Question: Describe this figure in one sentence.
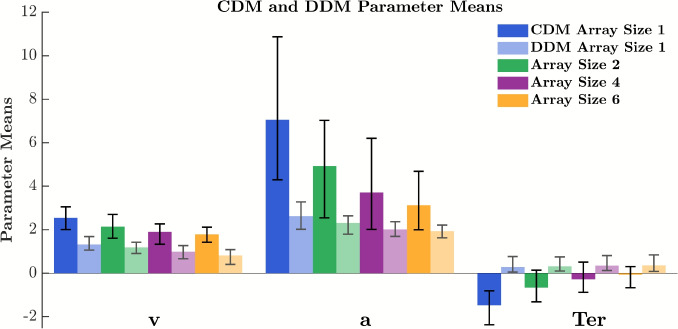
Answer: Mean drift rate (v), boundary separation (a) and non-decision time (Ter) parameters across participants and set sizes (colors) for the EZ-CDM and EZ-DDM. Data only includes responses contained within the central von Mises component of the initial recall response, per (Qarehdaghi & Rad, 2024 )